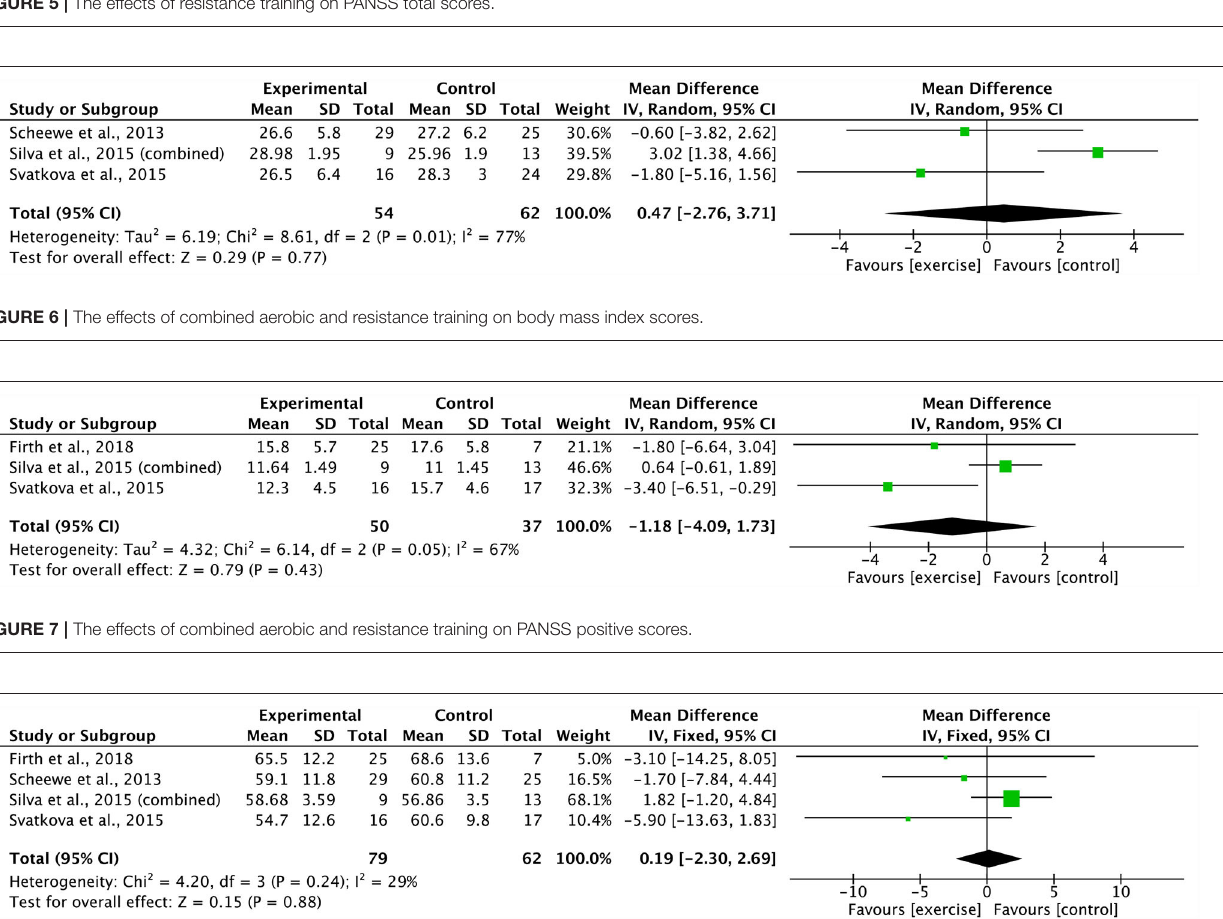
FIGURE 5 | The effects of resistance training on PANSS total scores.